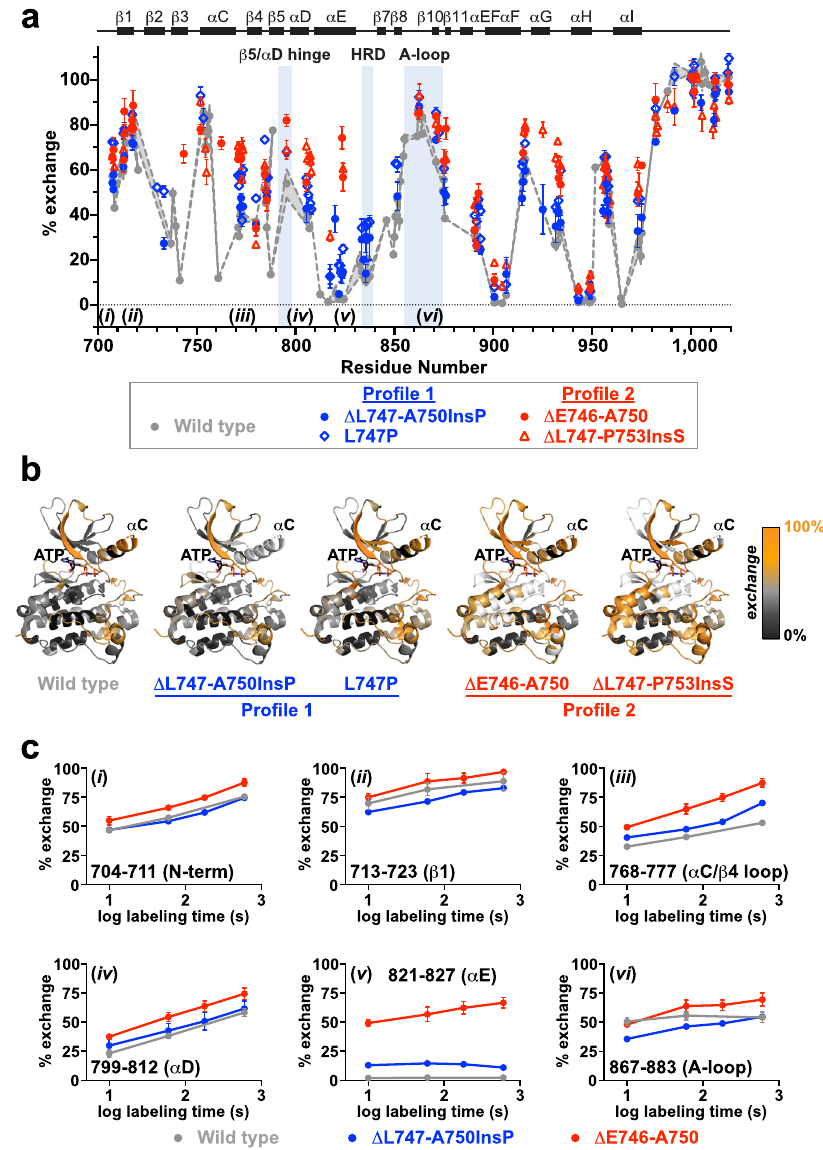
Fig. 4 | Native state dynamics ofexon19 variantsdiffer for pro fi le1 and pro fi le 2. a Backbone amide hydrogen exchange from HDX-MS experiments for all analyzable peptides at the 1min labeling timepoint for wild type (grey circles), Δ L747-A750InsP (blue circles), L747P (blue diamonds), Δ E746-A750 (red circles), and Δ L747-P753InsS (red triangles) variants without ATP or inhibitor. Mean per- cent exchange (± SD) for three independent experiments across each of three separate protein preparations (two for Δ L747-A750InsP) is plotted against the median residue number of the peptide in wild type EGFR numbering. Secondary structureelementpositions aredenotedatthe topofthe fi gure,with functionally important regions ( β 5/ α D hinge, HRD motif, and activation loop) indicated. Wild type data are represented by two dashed grey lines corresponding to the range (± SD) for each point. The Δ E746-A750 and Δ L747-P753InsS variants both showed EX1 kinetics 48 in the HRD and DFG motif regions, so these data are shown sepa- rately (see Fig. 6). Positions of peptides i through vi (see c ) are denoted at the bottom of the graph. b 1min percent exchange data for the indicated EGFR